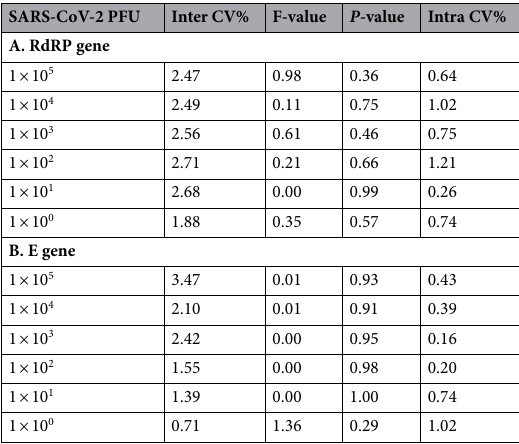
Table 5. Accuracy and precision of RT-qPCR amplification of SARS-CoV 2 RdRp and E genes from a lower respiratory tract mucus sample from the first patient confirmed to have COVID-19 in South Korea. P value > 0.05 indicates no difference between days. F value < 5.99 indicates no difference between days. F(1,6; 0.05) = 5.99; CV(%): Coefficient of variation.